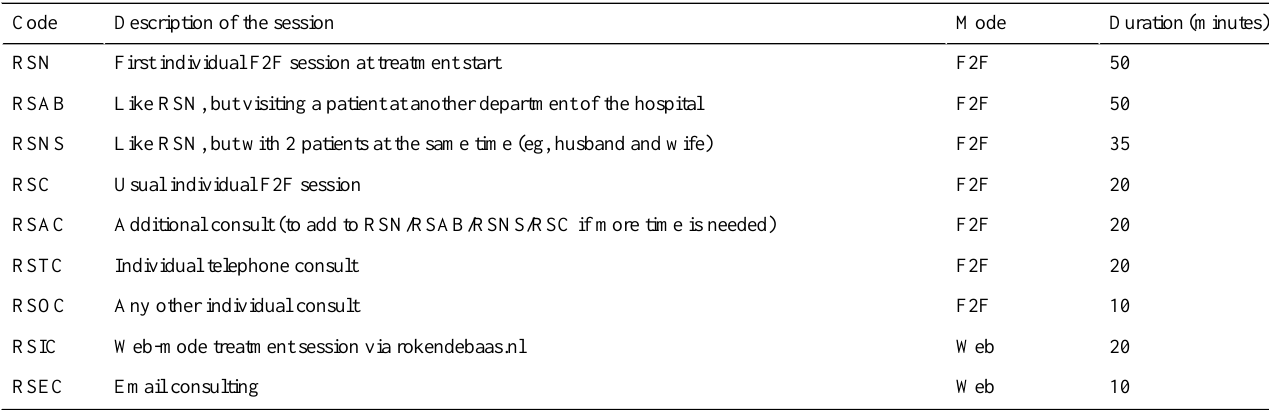
Table 2. Codes, descriptions, modes of delivery, and duration of face-to-face (F2F) and blended treatment sessions used to measure adherence.